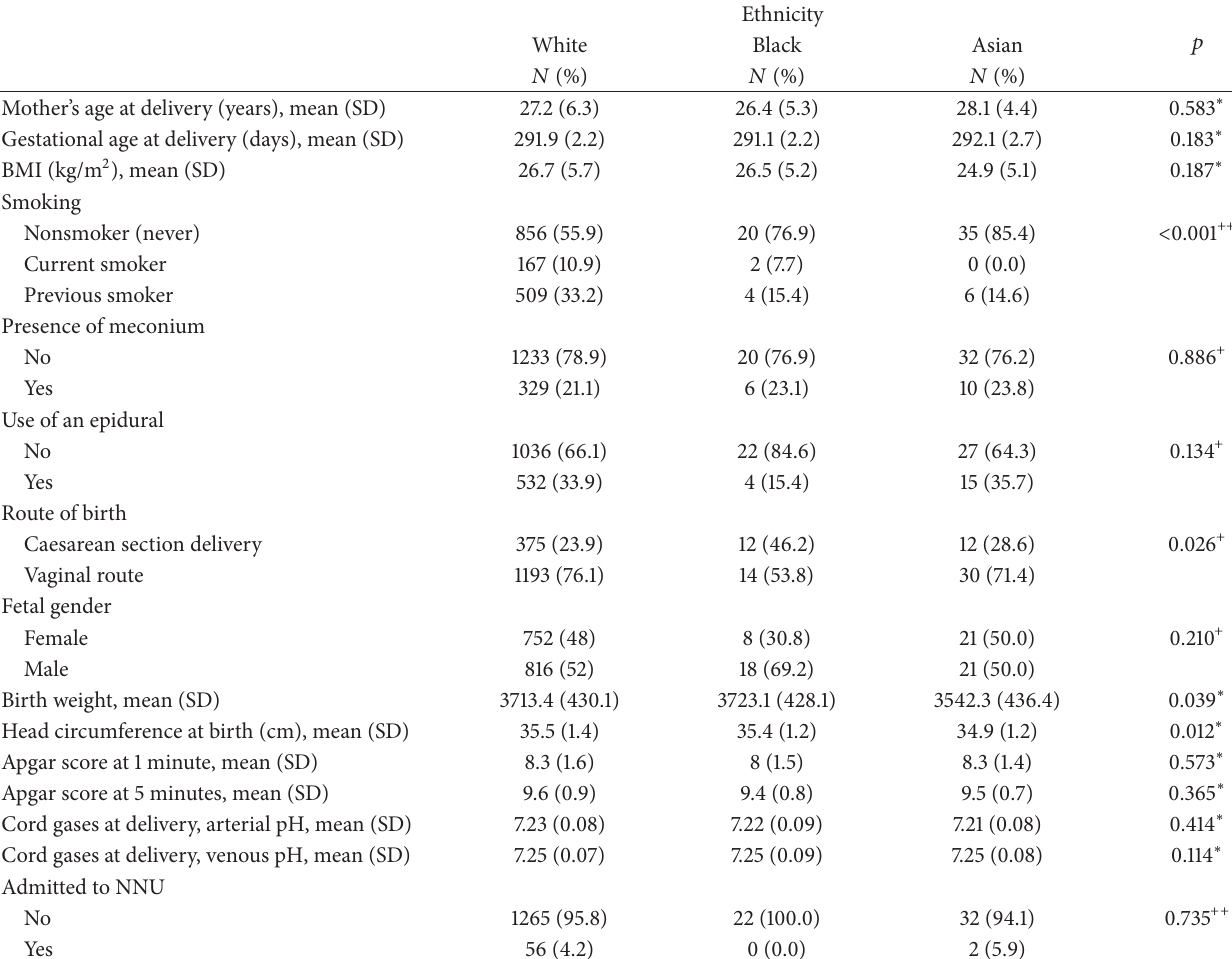
Table 2: Demographics and perinatal characteristics by ethnic